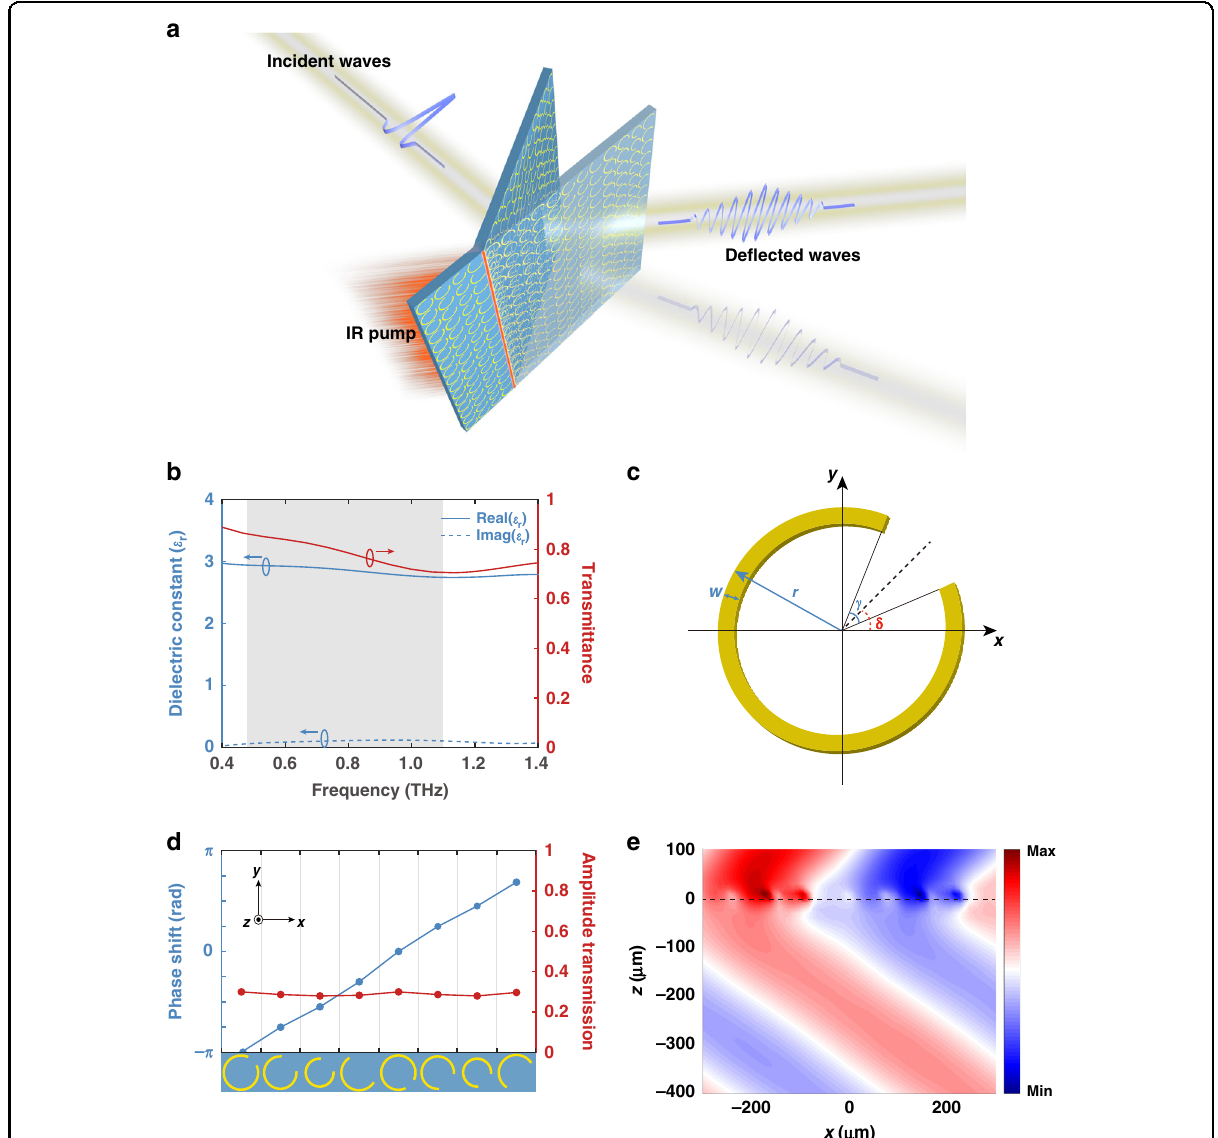
Fig. 2 Design of the active LCE metasurface. a Illustration of the infrared regulation of the LCE metasurface. b The dielectric constant and THz transmittance of LCE in the interested bandwidth. c Schematic of the CSRR. d The phase shift (blue dot line) and the transmission amplitude (red dot line) of the selected eight CSRRs. e Simulated refraction on the designed metasurface at 0.8 THz. The black dashed line indicates the position of the metasurface